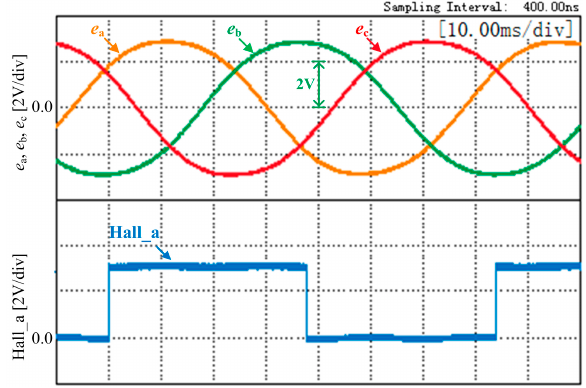
Figure 13. The measured three phases back-EMF and Hall signal of phase-a at 200r/min.